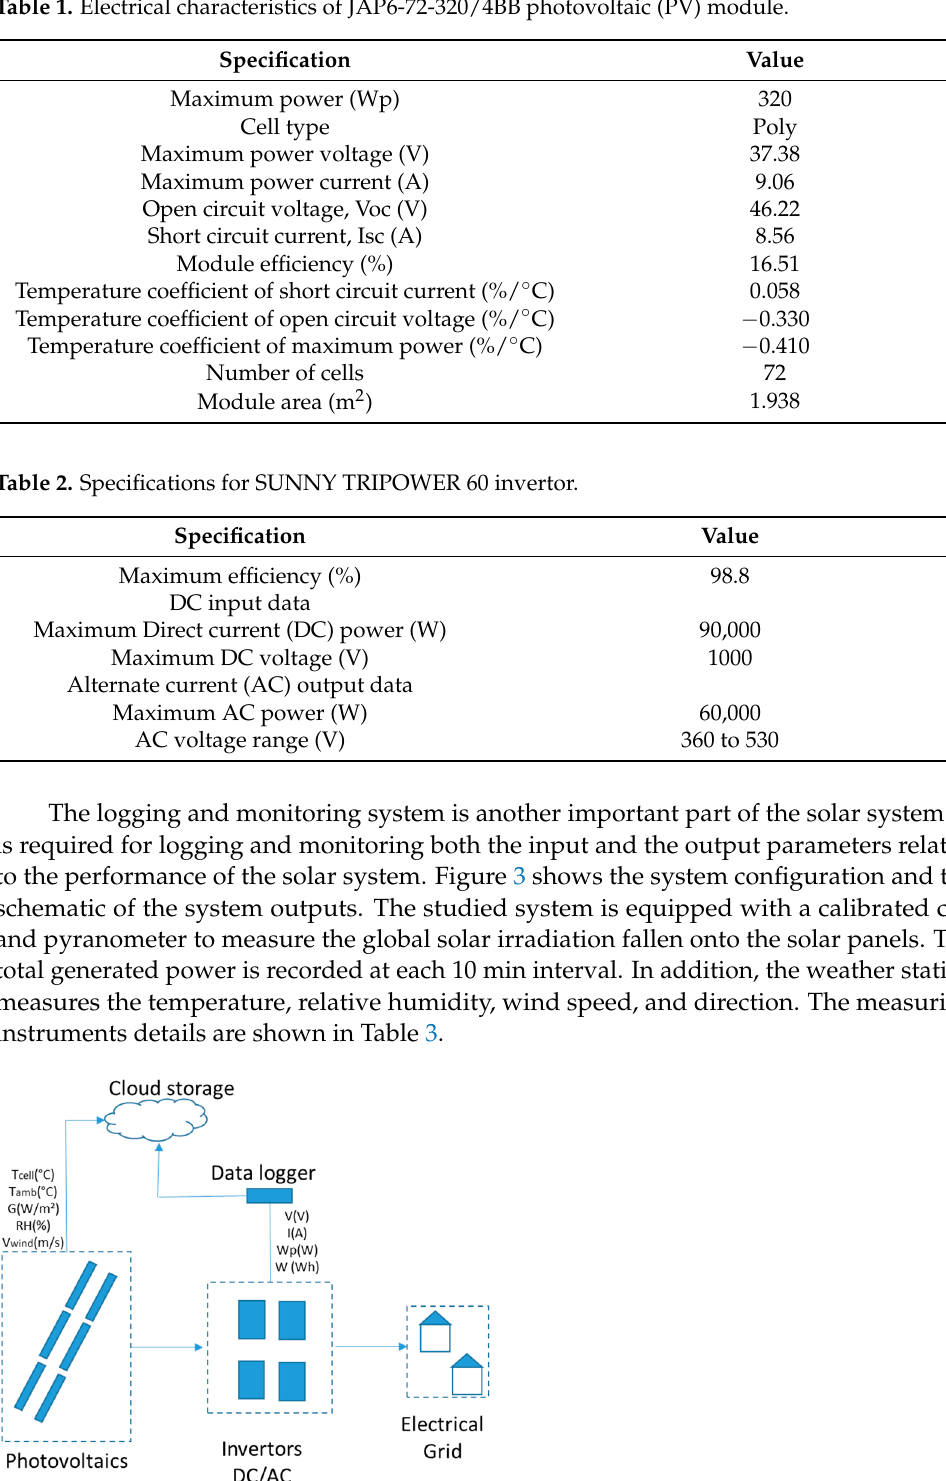
Table 1. Electrical characteristics of JAP6-72-320/4BB photovoltaic (PV) module.